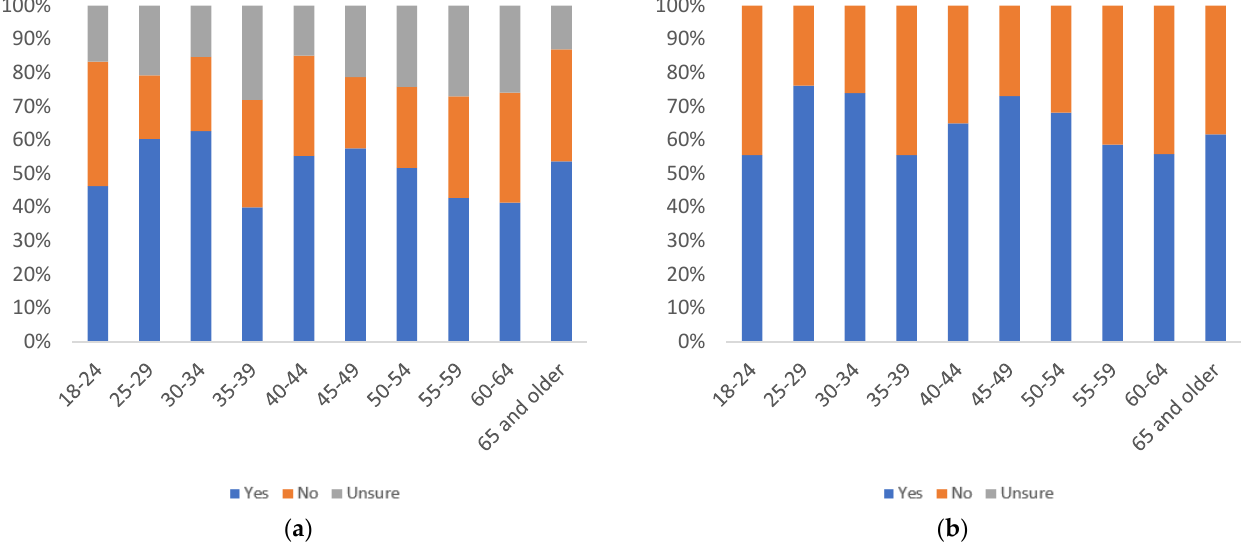
Figure 33. Label trustworthiness judging use, by age group: ( a ) with uncertain respondents (left) and ( b ) without uncertain respondents (right).